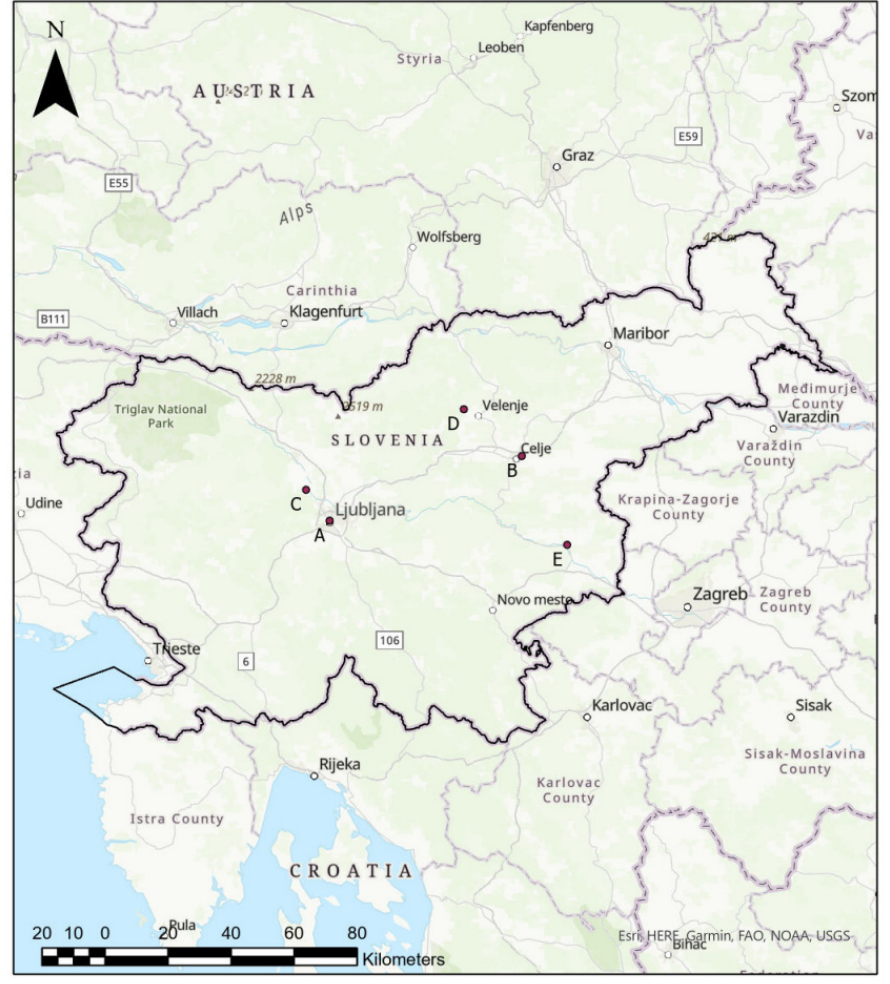
Figure 1. The geographical location of the study area with marked monitoring stations (A—traffic, B—background, C—background, D—industrial, and E—background).